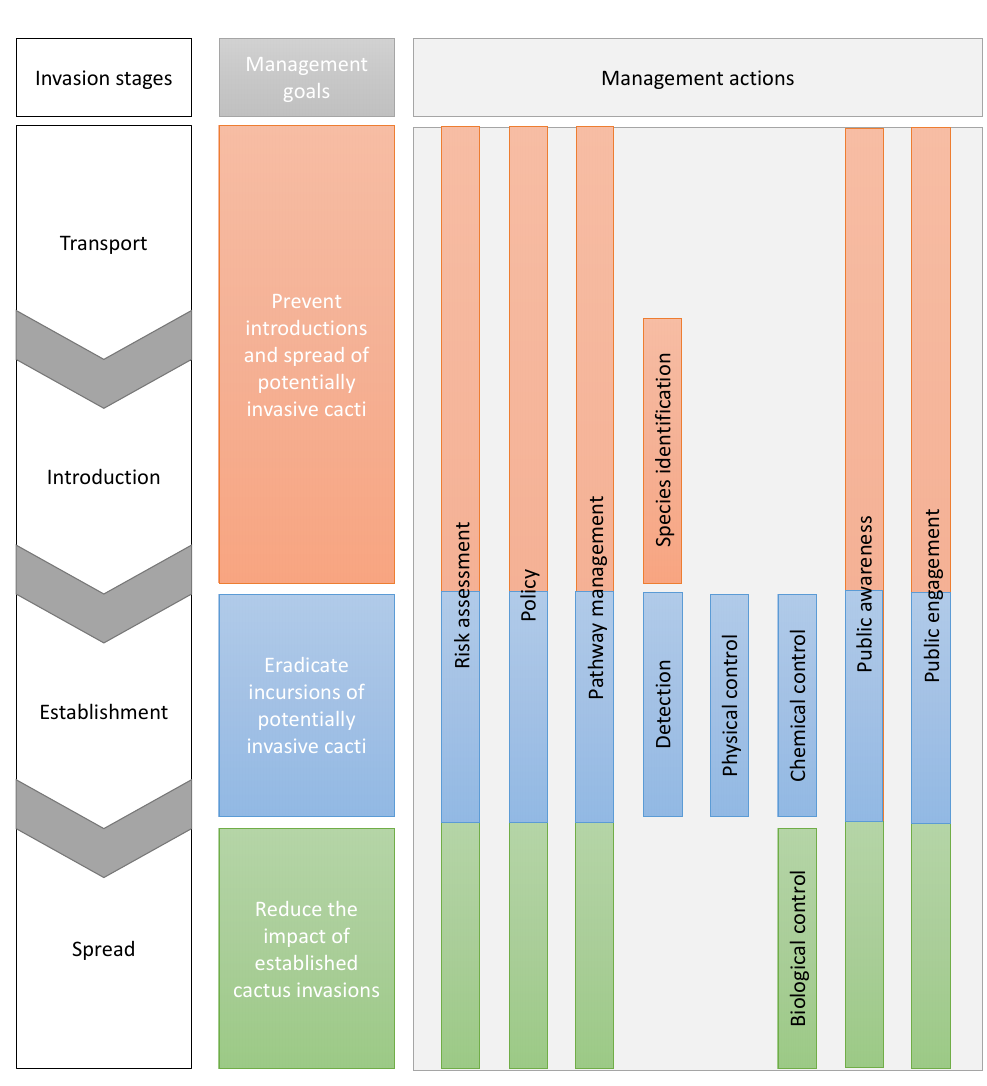
Figure 1. Overview of different actions through which goals of managing cactus invasions can be achieved. Invasion stages are based on the unified framework for biological invasions [37].